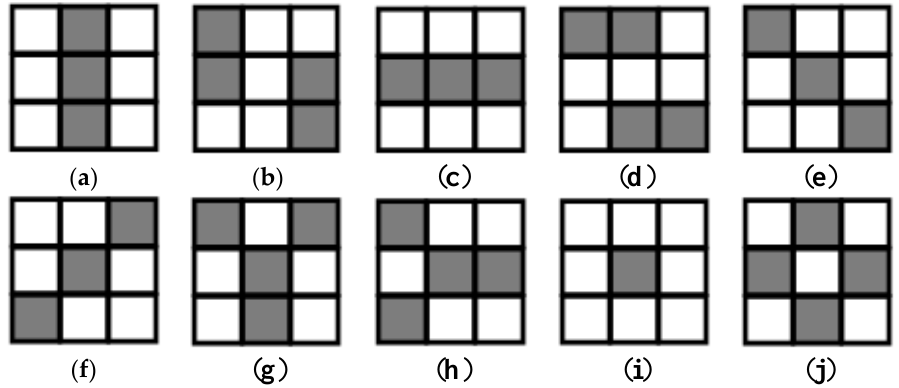
Figure 8. The different feature extraction modes. ( a )Vertical Mode1; ( b ) Vertical Mode2; ( c ) Horizontal Mode1; ( d ) Horizontal Mode2; ( e ) Descending Mode; ( f ) Ascending Mode; ( g ) T Mode1; ( h ) T Mode2;